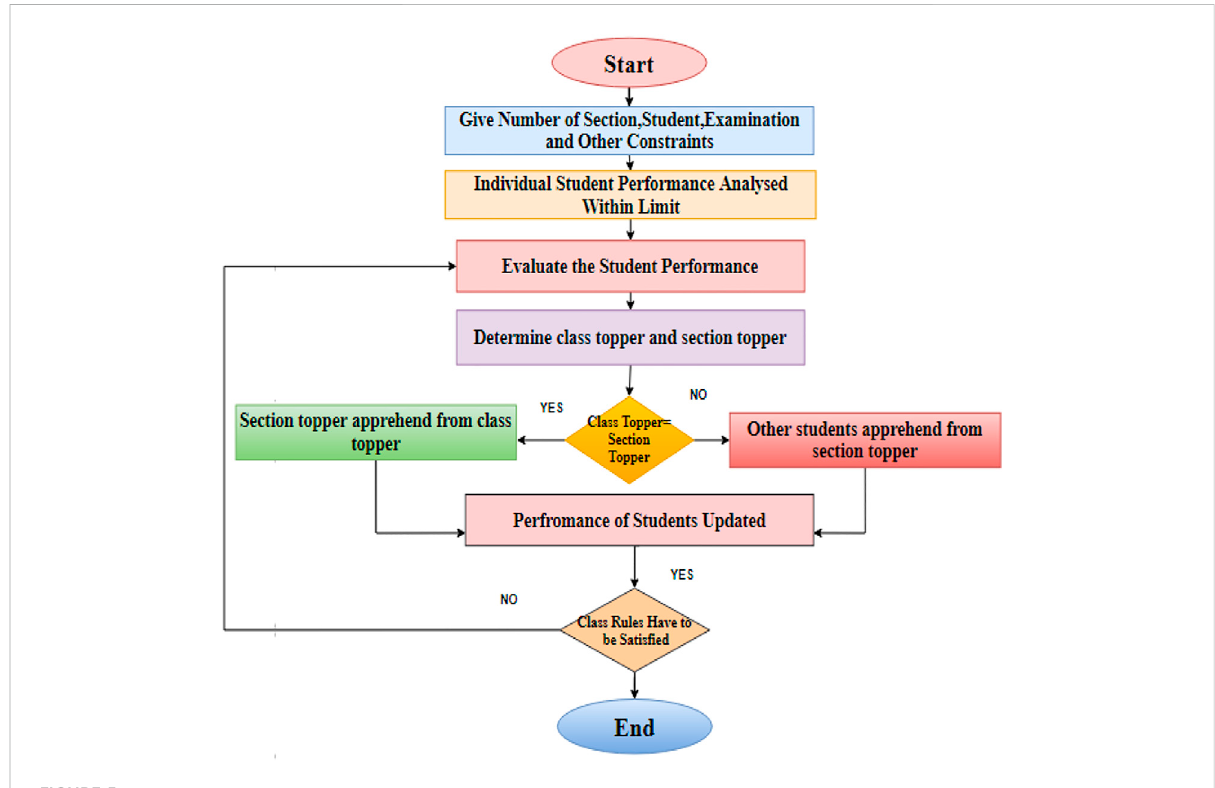
FIGURE 5 Optimization technique fl owchart.